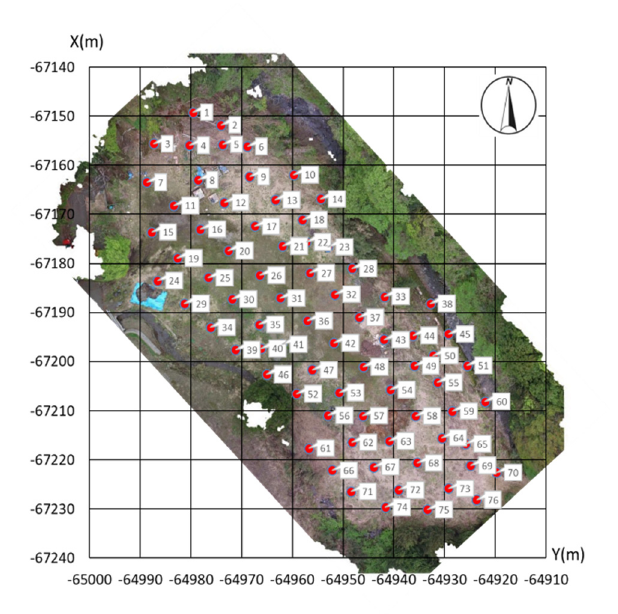
Figure 2. 76 ground marks in test site